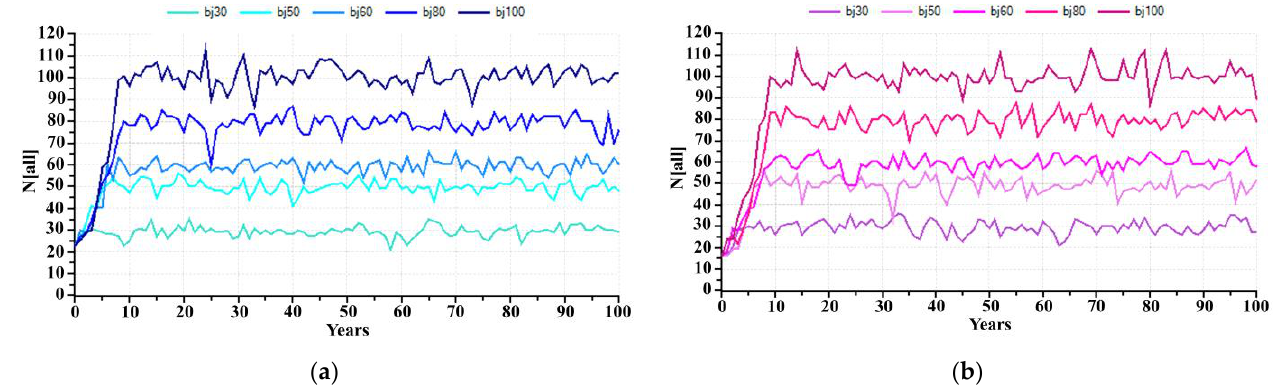
Figure 5. The number of captive banteng in 100 years with the carrying capacity at 30, 50, 60, 80 and 100 individuals; ( a ) 23 founders and ( b ) 16